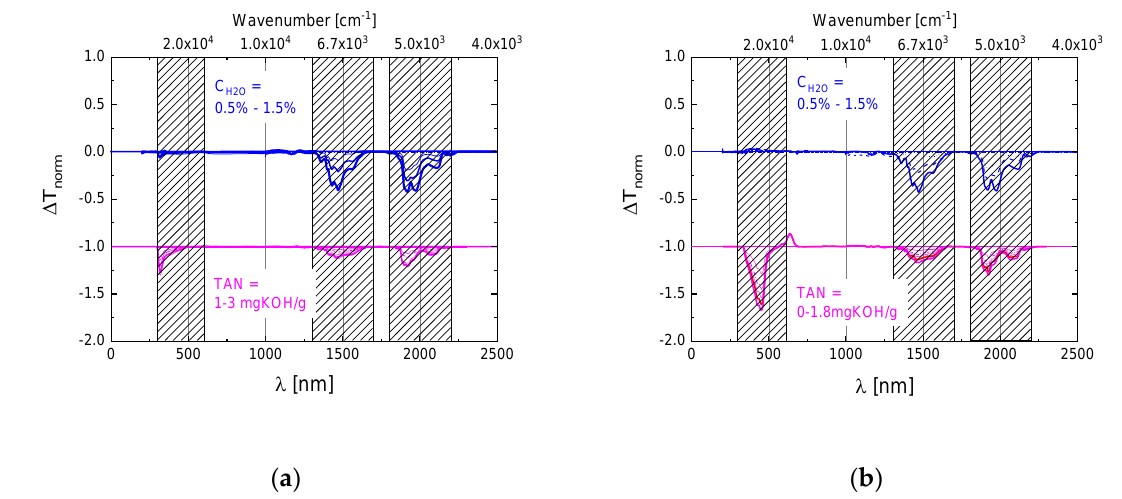
Figure 8. ( a ) Difference spectra of water-contaminated and thermally degraded Skydrol LD4 in the Figure 8. ( a ) Di ff erence spectra of water-contaminated and thermally degraded Skydrol LD4 in the NIR and VIS ranges (d opt = 1 cm) [6]. ( b ) Di ff erence spectra of water-contaminated and thermally degraded NIR and VIS ranges (d opt = 1 cm) [6]. ( b ) Difference spectra of water-contaminated and thermally HYJET V in the NIR and VIS ranges (d opt = 1 cm) degraded HYJET V in the NIR and VIS ranges (d opt = 1 cm) [6].